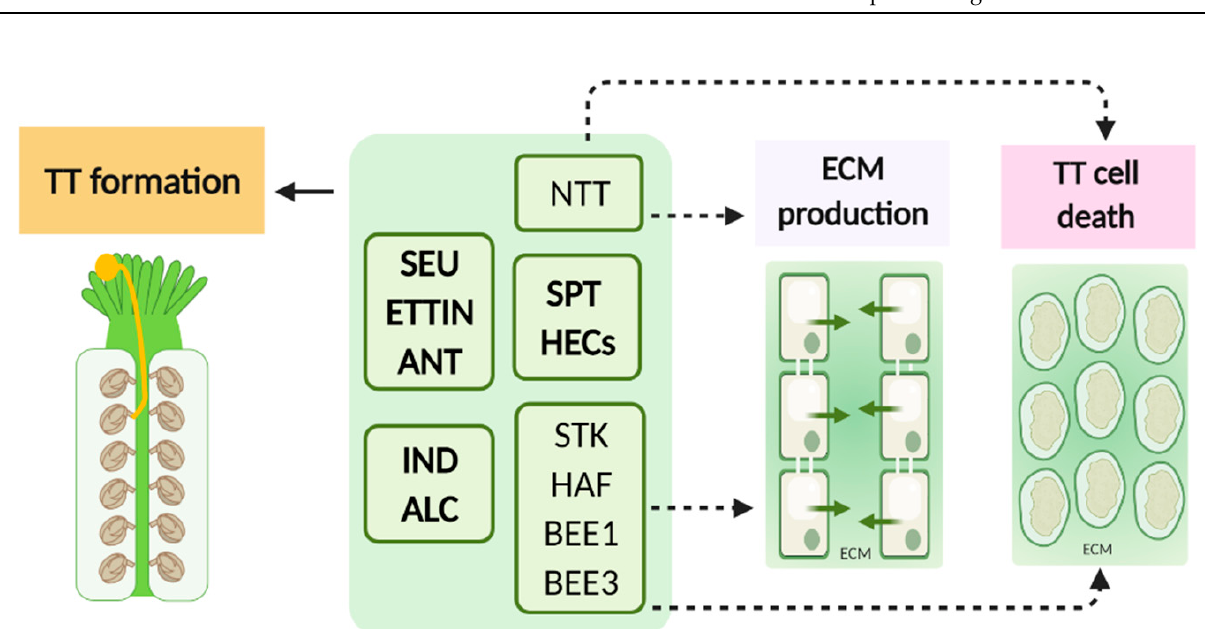
Figure 2. Key players involved in TT formation and development in Arabidopsis thaliana . So far, few main regulators involved in TT formation and development have been identified (NTT, NO TRANSMITTING TRACT; SPT, SPATULA; HEC1, 2, and 3, HECATE1, 2 and 3; STK, SEEDSTICK; HAF, HALF FILLED; BEE1 and BEE3, BRASSINOSTEROID ENHANCED EXPRESSION1 and 3) and a concrete genetic regulatory network has not been fully elucidated. NTT is necessary for TT differentiation. TT development is intimately related to correct carpel fusion and development; thus, several gene products that participate in such processes are also involved in TT formation (SEU, SEUSS; ETTIN; ANT, AINTEGUMENTA; IND, INDEHISCENT; ALC, ALCATRAZ). Proteins are grouped in different boxes according to the way they interact with each other. Created with BioRender.com (accessed on 25 February